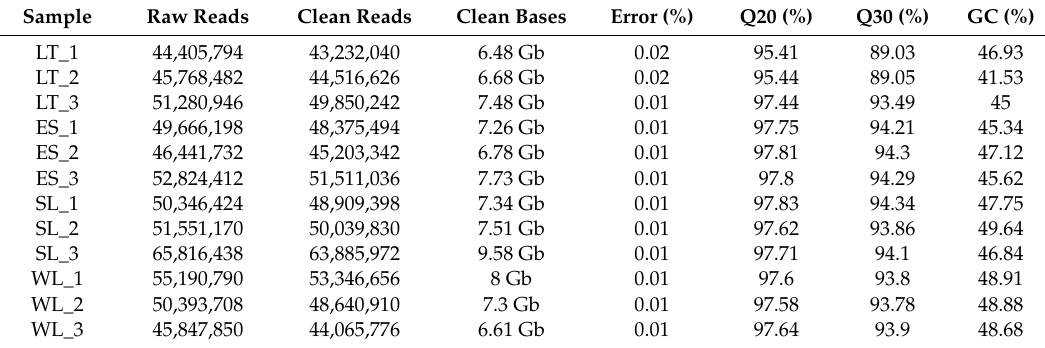
Table 1. Overview of the sequencing reads from the twelve larval transcriptomic libraries of U. unicinctus .